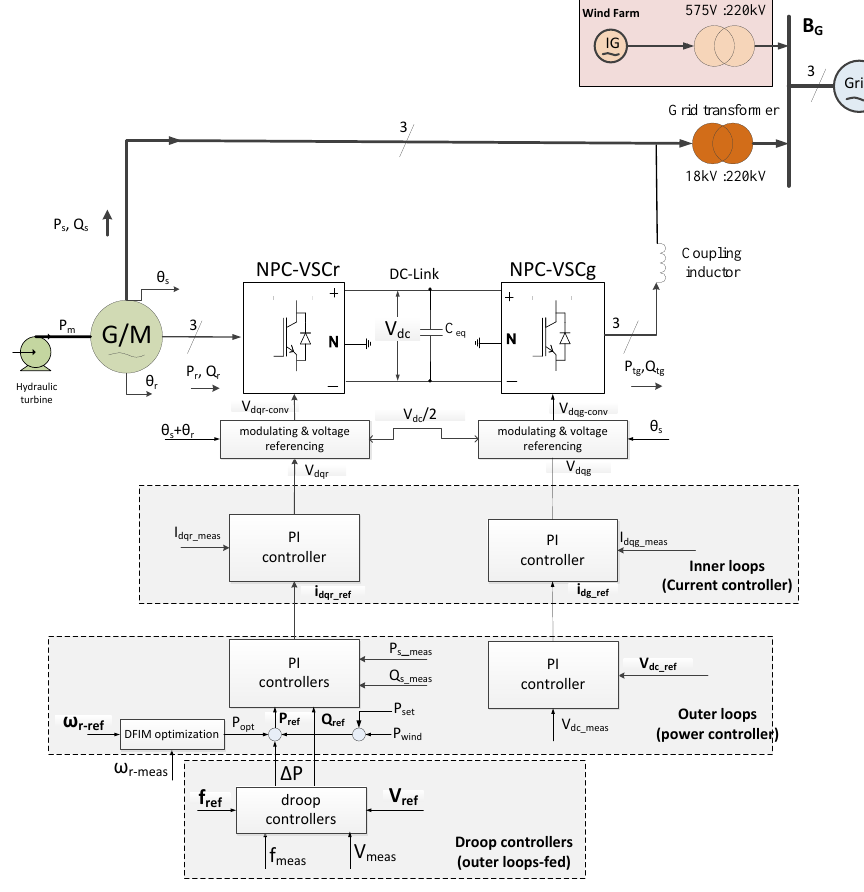
Figure 3. Structure of droop-fed vector control strategy for the NPC-VSC topology of the VSPS-wind- grid integrated system.